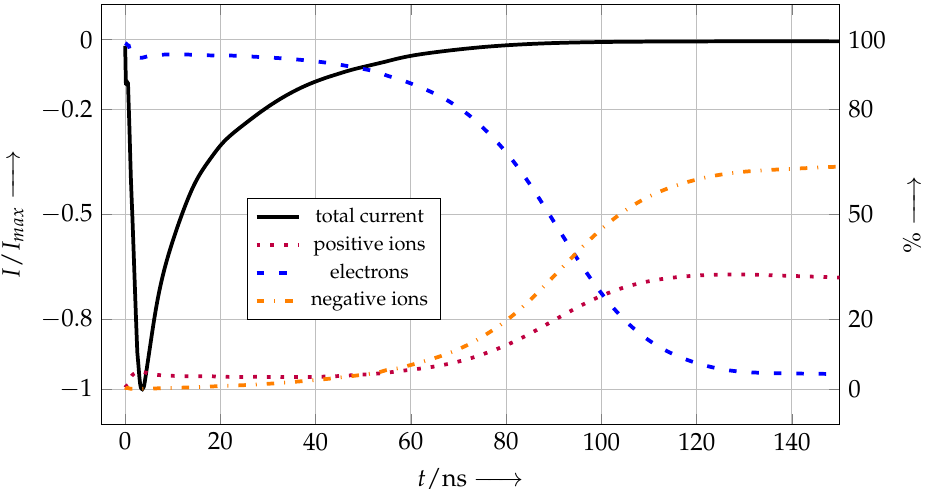
Figure 8. Simulated discharge current and proportions of the different charge carrier